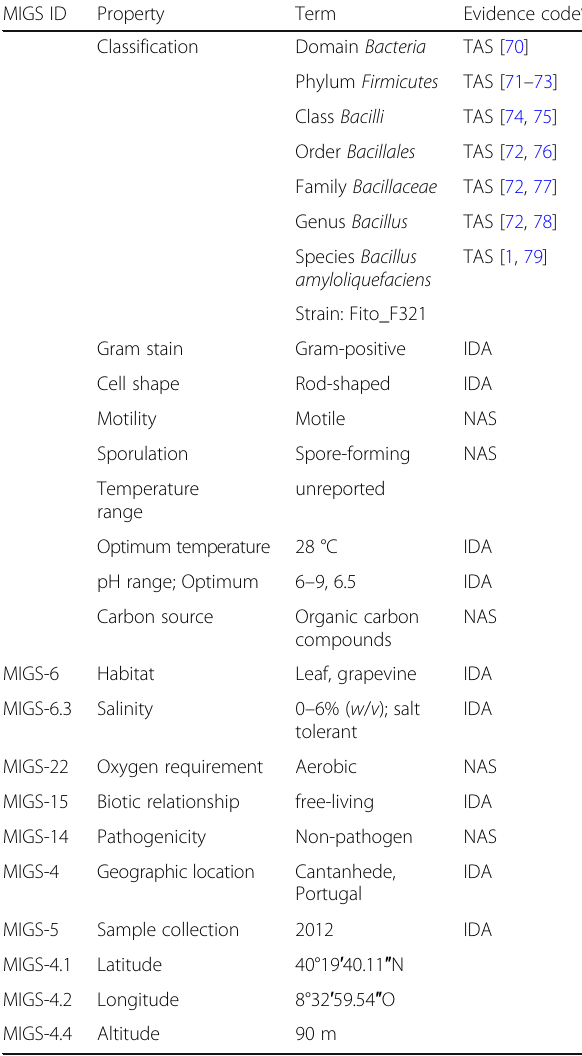
Table 1 Classification and general features of Bacillus amyloliquefaciens subsp. plantarum strain Fito_F321,